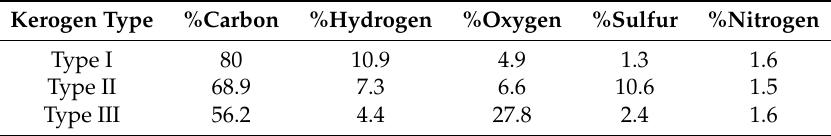
Table 4. Average elemental composition of C, H, O, S, and N in kerogen